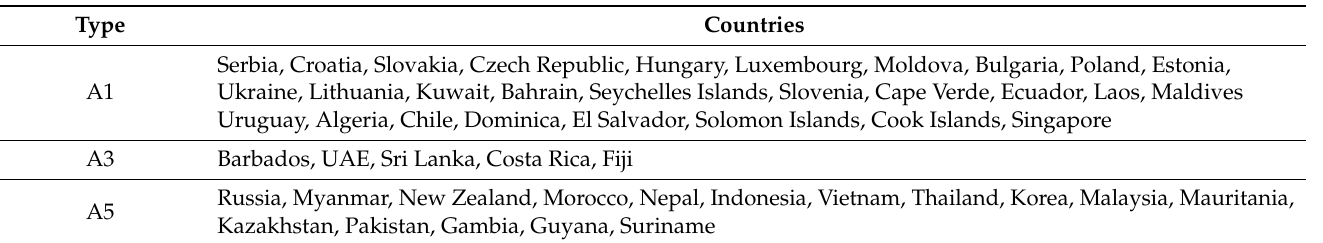
Table 4. Results of the analysis of the multilayer network of relations for category II agricultural